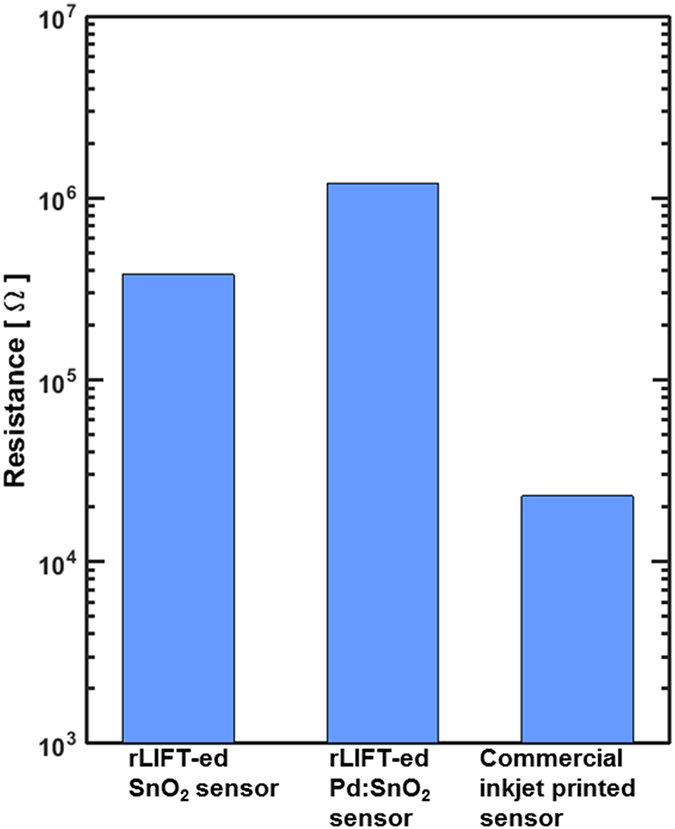
Base resistance at 350 °C of the LIFTed SnO2 sensors, Pt doped SnO2 sensors, and commercial inkjet printed sensors.